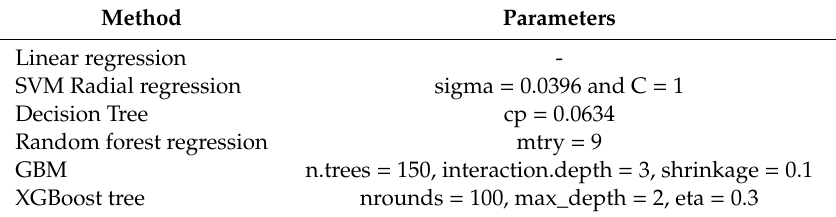
Table A1. Final Parameters for Likes